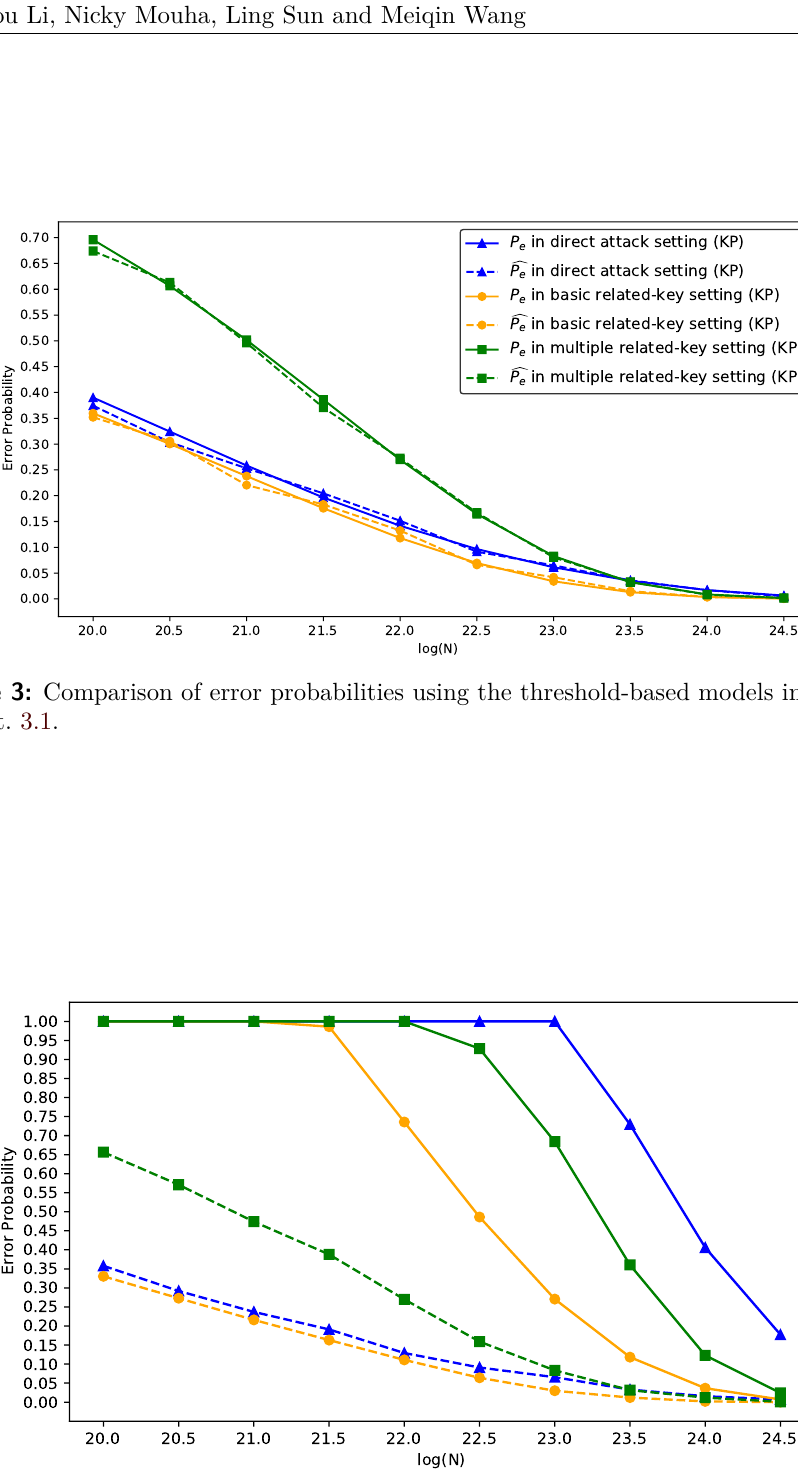
Figure 4: Comparison of error probabilities using models of Röck and Nyberg [RN13]. The legend of this graph is the same as Fig.